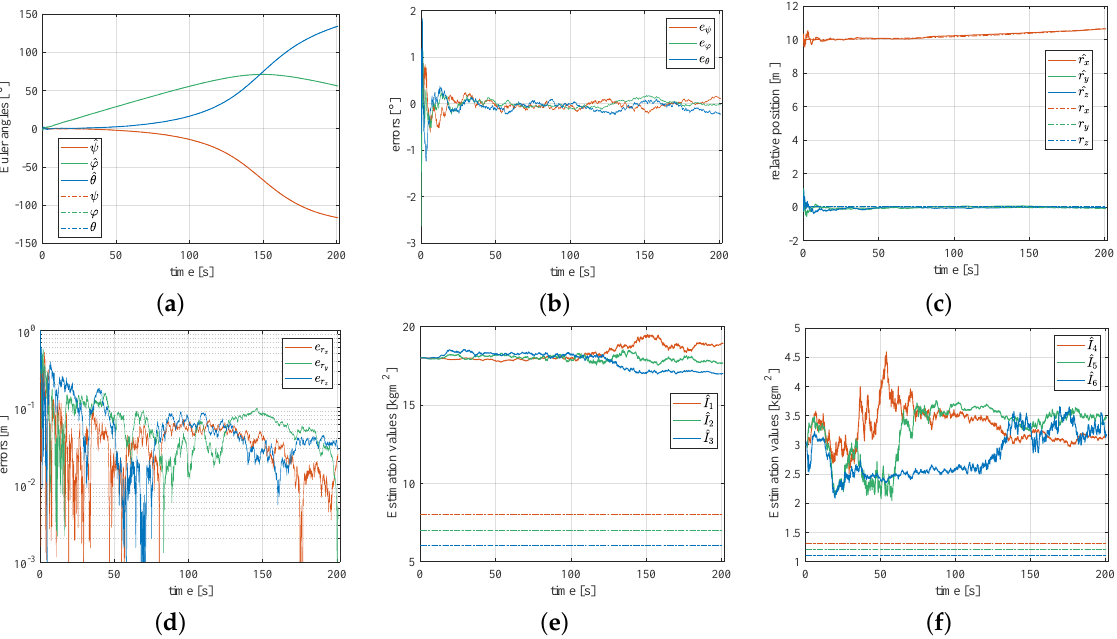
Figure 5. The estimations of the state variables of the object before the collision: ( a ) Euler angles esti- mations; ( b ) errors of the Euler angles estimations; ( c ) relative position estimations; ( d ) errors of the rel- ative position estimations; ( e ) the moment of inertia estimations; ( f ) the product of inertia